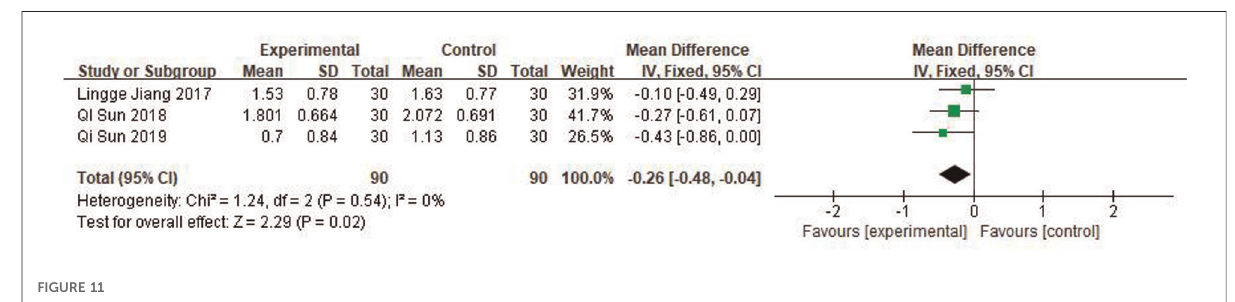
FIGURE 11 Forest plot showing the signs of turbinate